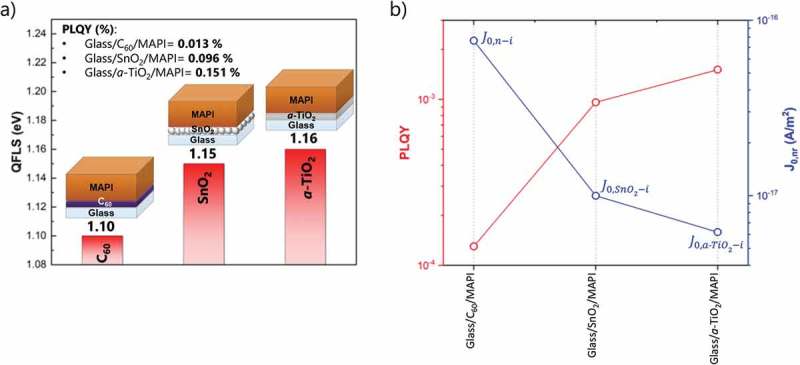
(a) Calculated QFLS of the different-investigated heterojunctions (glass/C60/MAPI, glass/SnO2/MAPI and glass/a-TiO2/MAPI/Spiro). (b) PLQY and individual J0,nr contributions for the different ETL/MAPI interfaces.